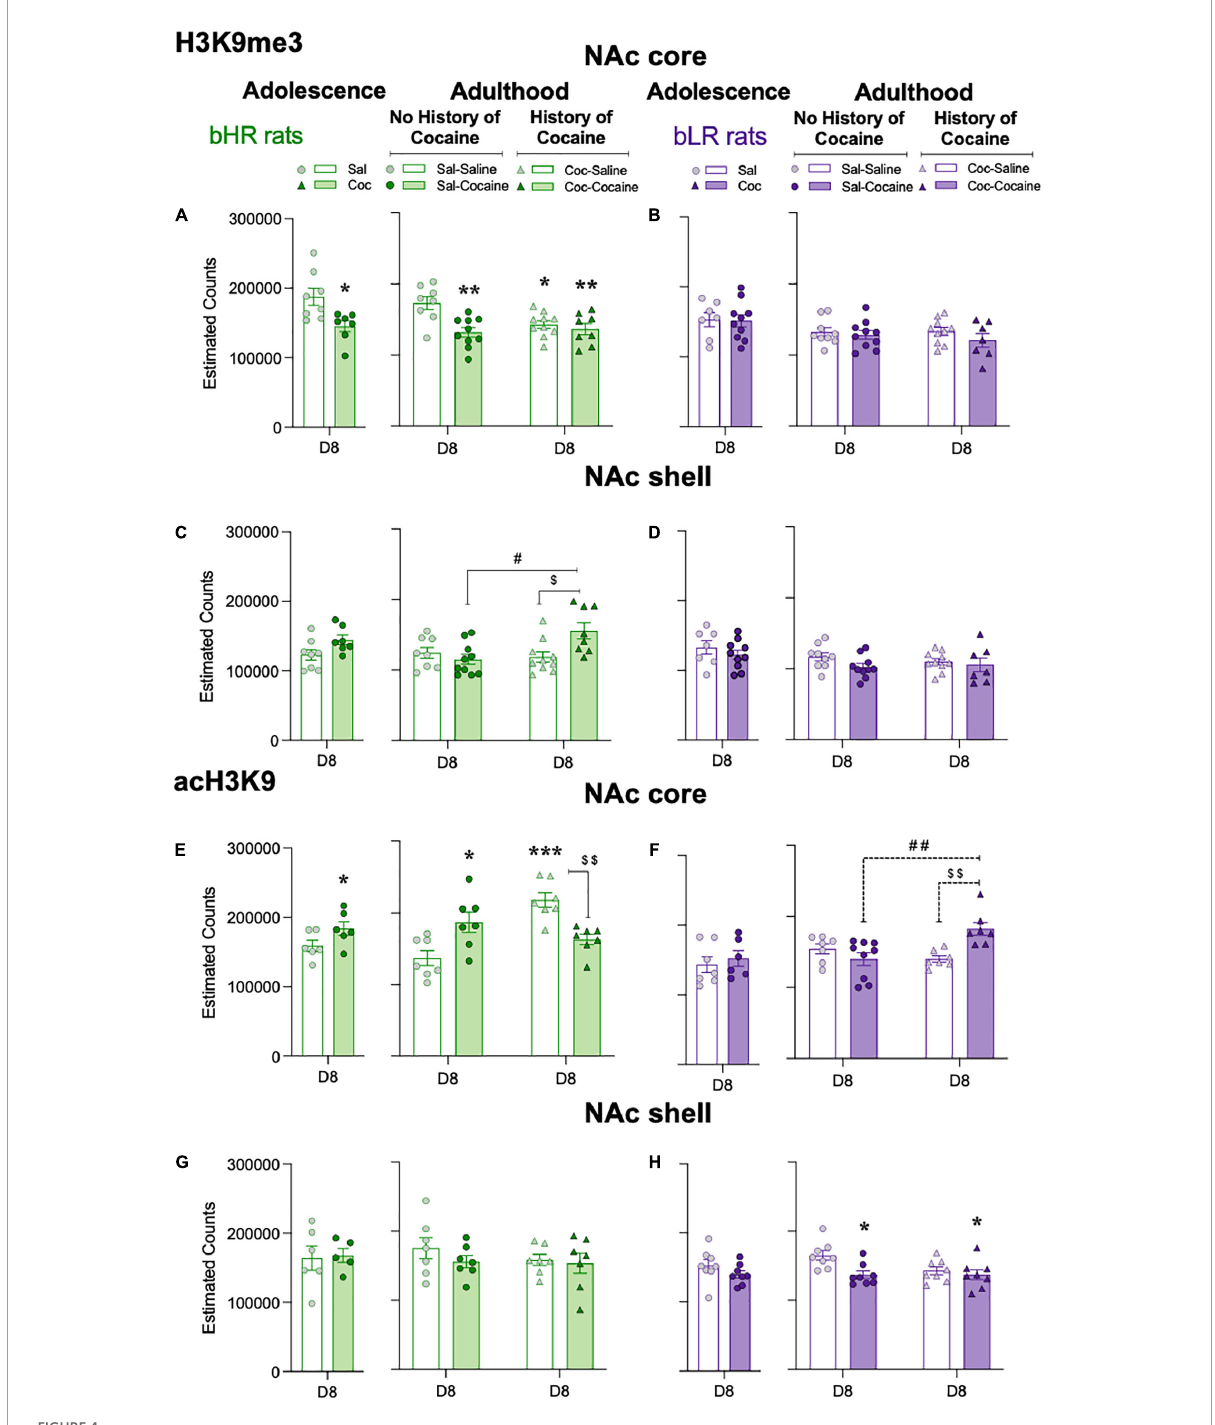
FIGURE4 Adolescent cocaine differentially impacts epigenetic levels in the nucleus accumbens core of divergent affective phenotypes. Repressive H3K9me3 (A–D) and permissive acH3K9 (E–H) cell counts in the NAc core and shell of bHRs and bLRs treated with adolescent and/or adult cocaine. Data represents the mean values ± SEM of the estimated cell counts of each marker as measured 24 h post-adolescent or adult treatment (D8). Individual values are shown for each rat (symbols). Student t -tests were performed to assess the effects of adolescent cocaine, while two-way ANOVAs were utilized following the adult treatment (see Supplementary Table 1 for more details). * p < 0.05, ** p < 0.01, and *** p < 0.001 when comparing cocaine-treated rats with the corresponding saline-treated group (main Effect of Treatment). ## p < 0.01 and # p < 0.05 when comparing rats with and without a prior history of adolescent cocaine (Coc-Cocaine vs. Sal-Cocaine). $$ p < 0.01 and $ p < 0.05 when comparing Coc-Cocaine vs. Coc-Saline